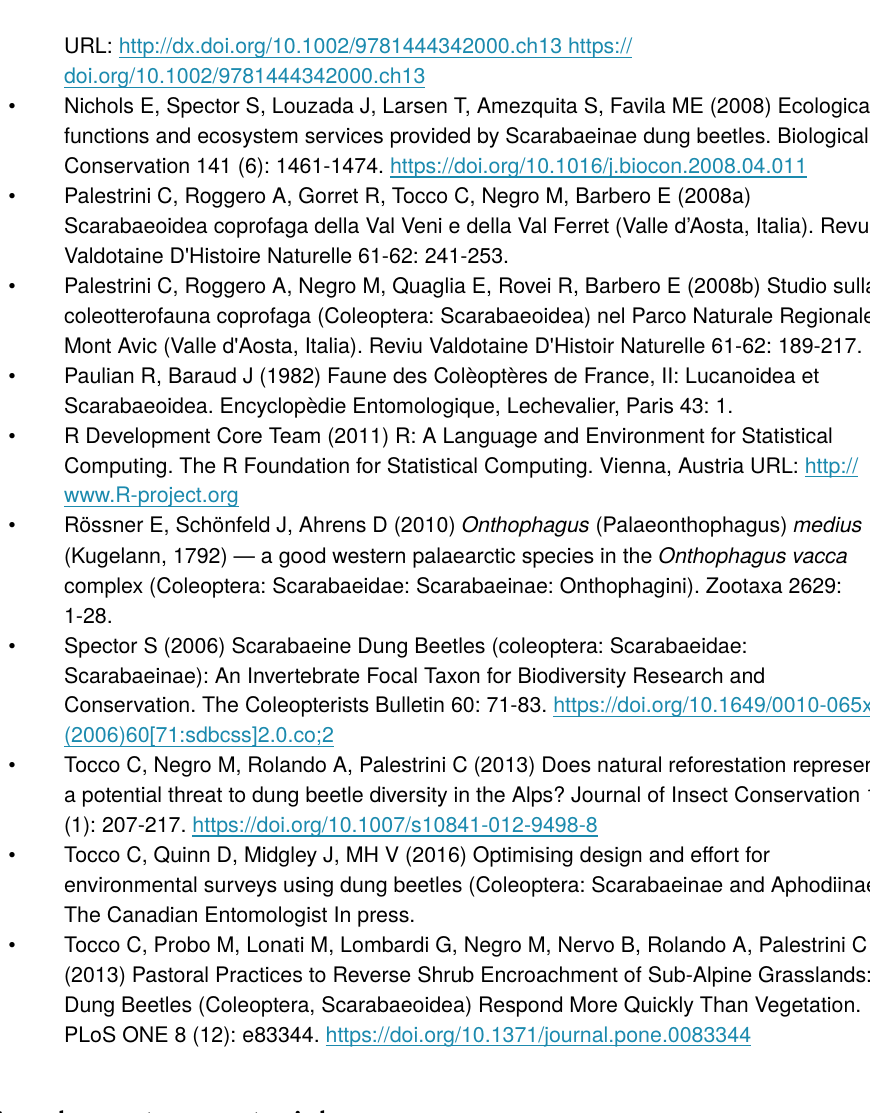
Supplementary material Suppl. material 1: Dung beetles of Troncea